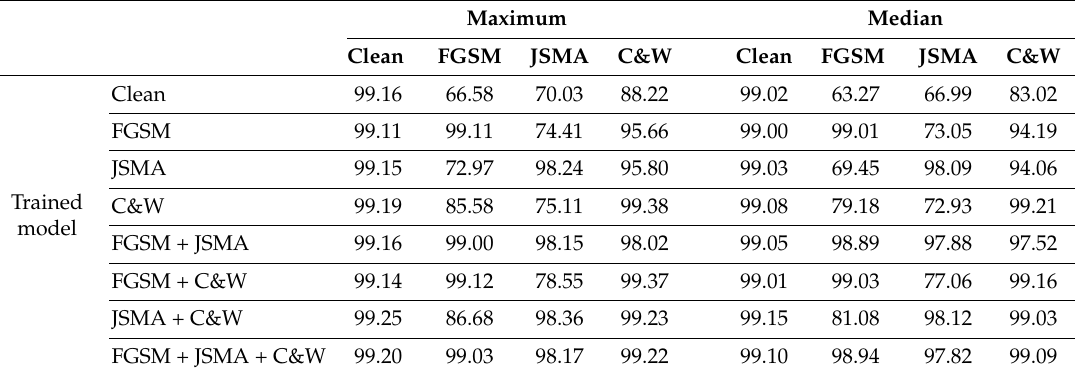
Table 4. Test accuracy of LeNet5 measured between 20 and 50 epochs. The network is trained without data augmentation techniques such as random rotation and random